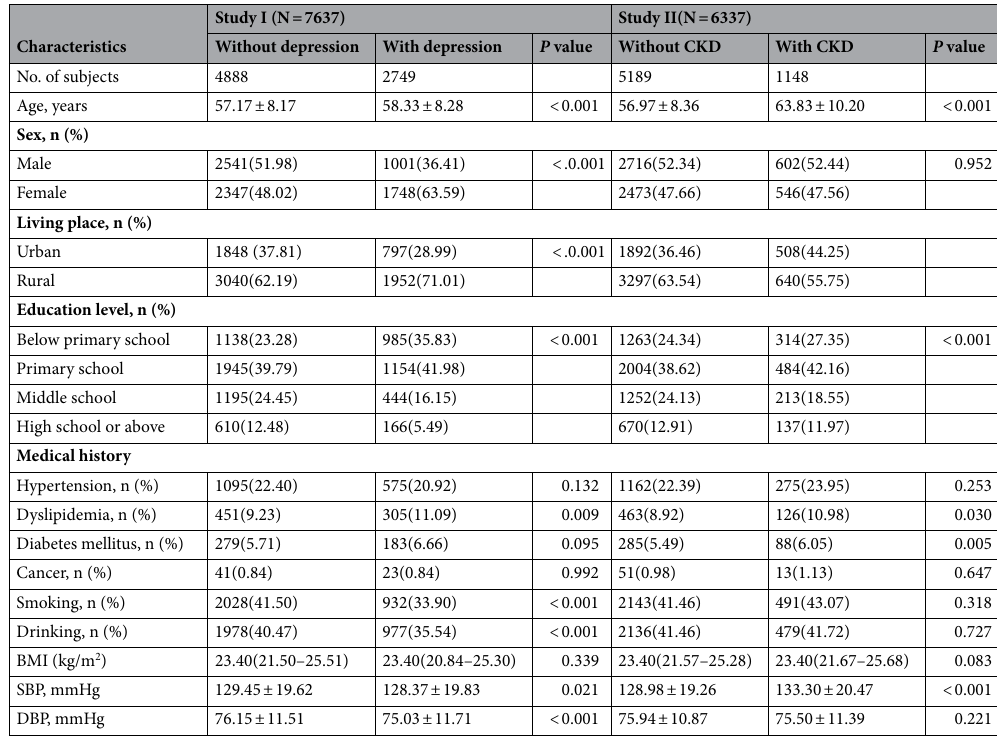
Table 1. Characteristics of the study population at baseline in study I and study II. BMI: body mass index; SBP: systolic blood pressure; DBP: diastolic blood pressure; Continuous variables are expressed as mean ± standard deviation, or as median (interquartile range). Categorical variables are expressed as frequency (percent). † CKD eGFR < 90 mL/min per 1.73 m 2 or with reported kidney diseases.